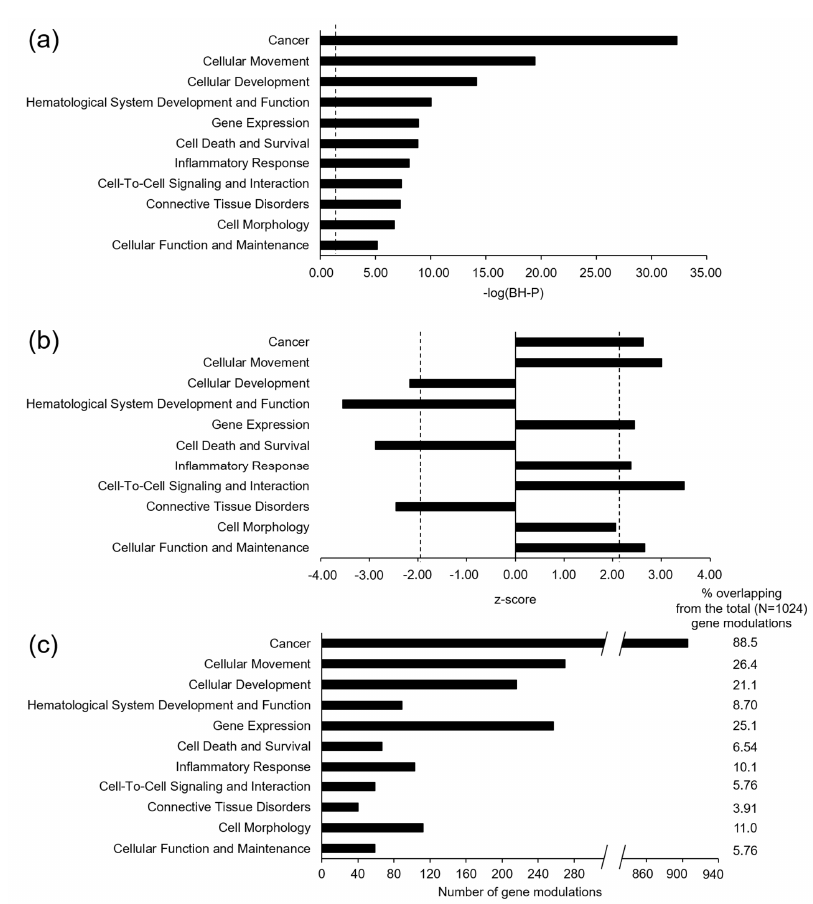
Figure 2. Diseases and biological functions predicted to be modulated in elderly individuals with T2D ( a , b ), and the number of genes involved in each of them ( c ). Significant modulations were defined by -logarithm of Benjamini–Hochberg-adjusted p value ( − log(BH- P )) ≥ 1.30 ( a ) and an absolute z-score ≥ 2.0 ( b ) (vertical dashed lines, where appropriate). change 1,024 to 1024 in this figure. response (z-score = 2.37, − log(BH- P ) = 8.03), cell-to-cell signaling and interaction (z-score = 3.47, − log(BH- P ) = 7.36), cell morphology (z-score = 2.06, − log(BH- P ) = 6.69), and cellular